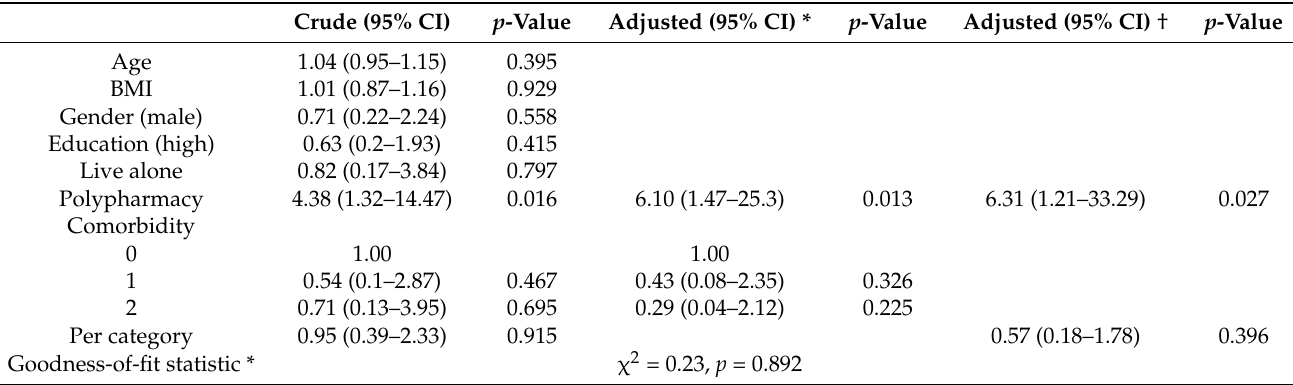
Table 4. Regression model of Study of Osteoporotic Fracture (SOF)